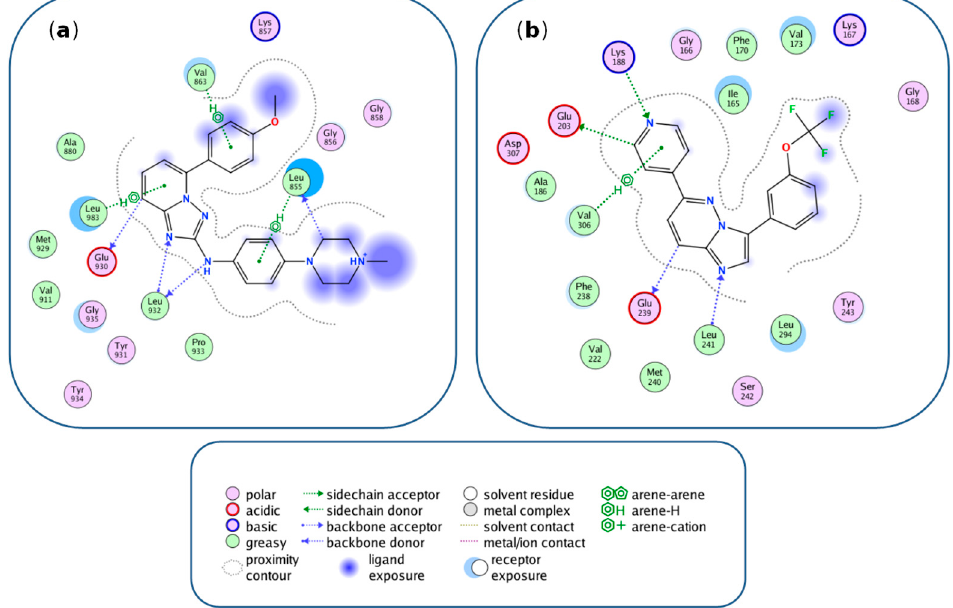
Figure 6. Kinase interactions with inhibitors containing characteristic substructures. Shown are kinase–inhibitor interaction diagrams derived from X-ray structures of kinase–inhibitor complexes using the Molecular Operating Environment (MOE, Chemical Computing Group, Inc., Montreal, QC, Canada). ( a ) shows a crystallographic inhibitor containing the [1,2,4]triazolo[1,5-a]pyridine substructure characteristic of MT-CPDs of triplet 1 in complex with JAK2 (PDB ID: 4JIA) and ( b ) an inhibitor with the imidazo(1,2-b)pyridazine substructure of MT-CPDs of triplet 2 in complex with DYRK1A (PDB ID: 6S11, Chain: A). At the bottom, different types of interactions accounted for in the diagram are specified. These interaction types were automatically classified using MOE. We note that under physiological conditions, interactions between the charged glutamic acid residue and aromatic rings should best be perceived as anionic– π aromatic interactions.